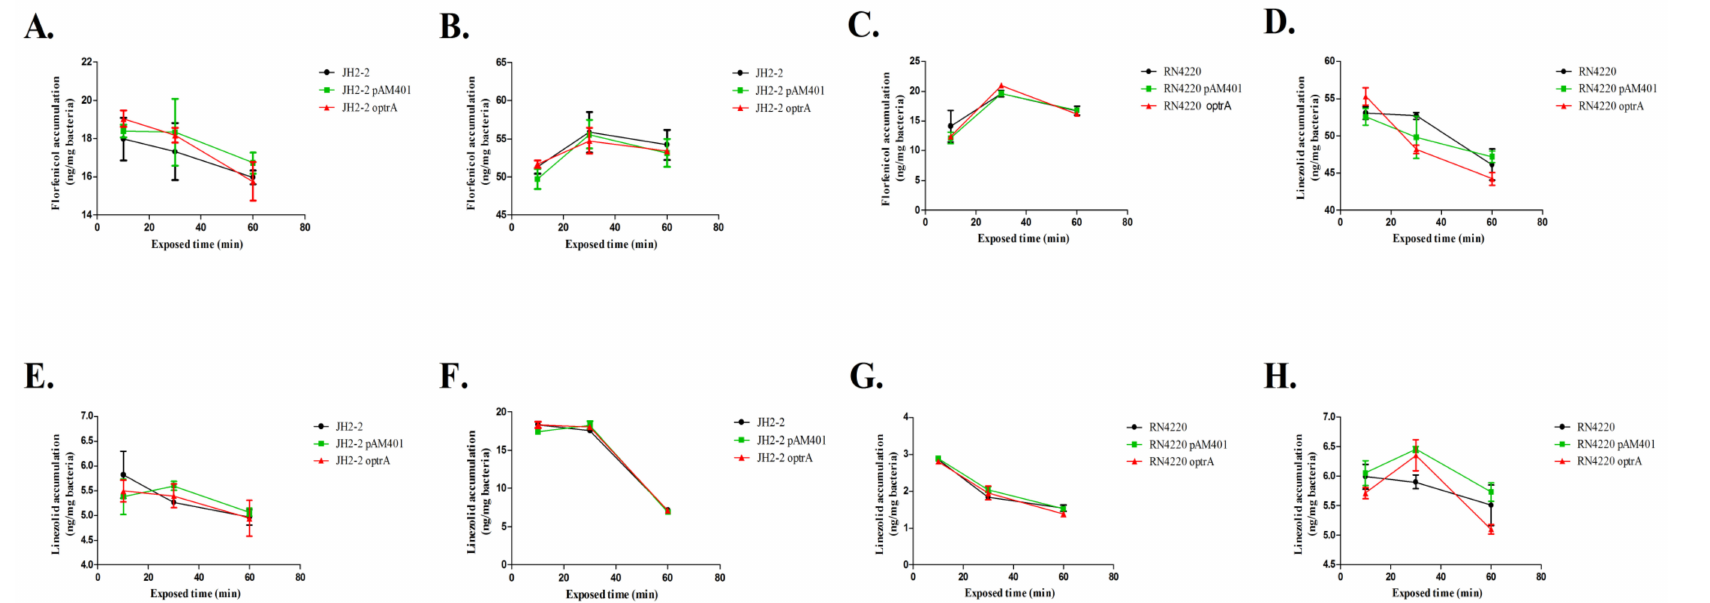
Figure 1. Accumulation of florfenicol and linezolid in the tested bacteria. ( A ) Florfenicol at concentration of 16 mg/L in E. faecalis . ( B ) Florfenicol at concentration of 64 mg/L in E. faecalis . ( C ) florfenicol at concentration of 16 mg/L in S. aureus . ( D ) Florfenicol at concentration of 64 mg/L in S. aureus . ( E ) Linezolid at concentration of 2 mg/L in E. faecalis . ( F ) Linezolid at concentration of 8 mg/L in E. faecalis . ( G ) Linezolid at concentration of 2 mg/L in S. aureus . ( H ) Linezolid at concentration of 8 mg/L in S. aureus